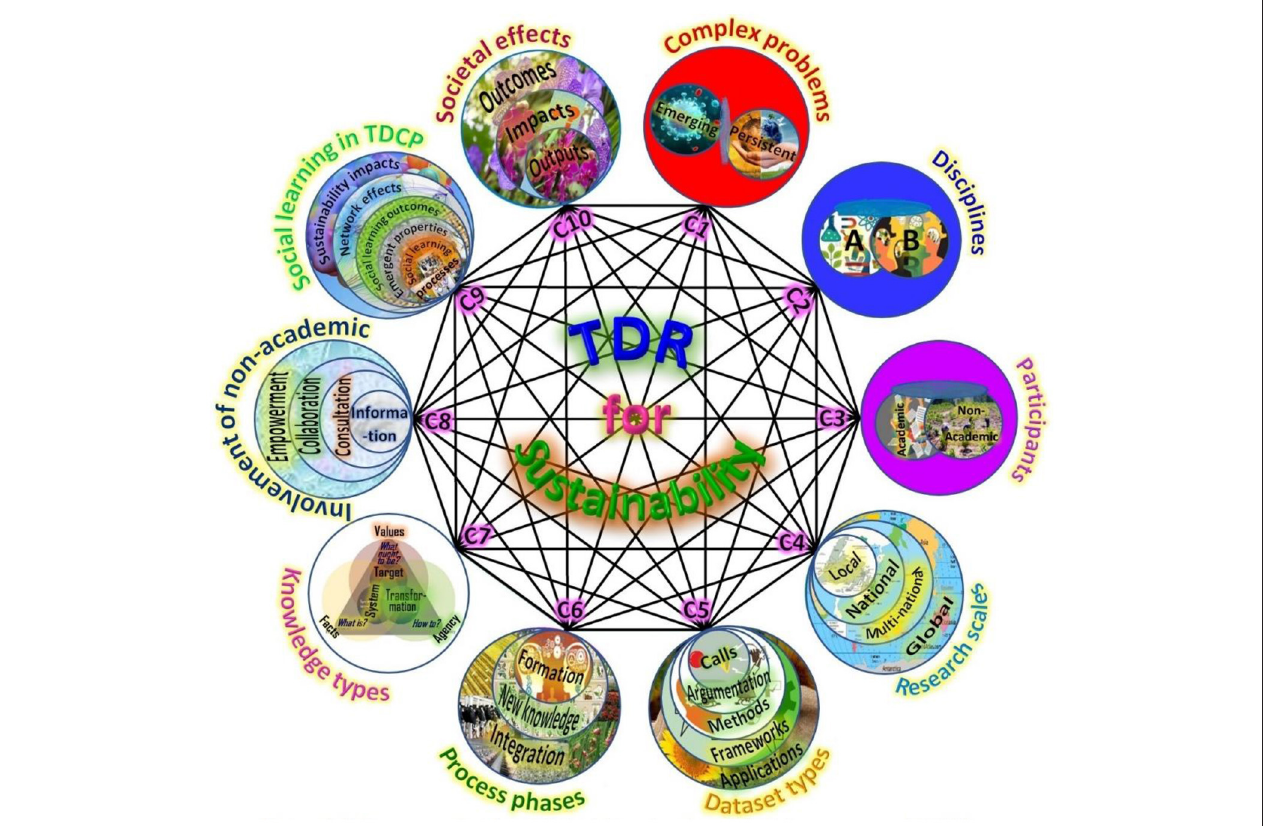
FIGURE 1 | Overview of TDR for sustainability, synthesized from ProClim (1997), Pohl and Hirsch Hadorn (2007), Walter et al. (2007), Hadorn et al. (2008), Pohl (2010) , Stauffacher et al. (2010), Brandt et al. (2013), Ruppert-Winkel et al. (2015), Steelman et al. (2015), and Slater and Robinson